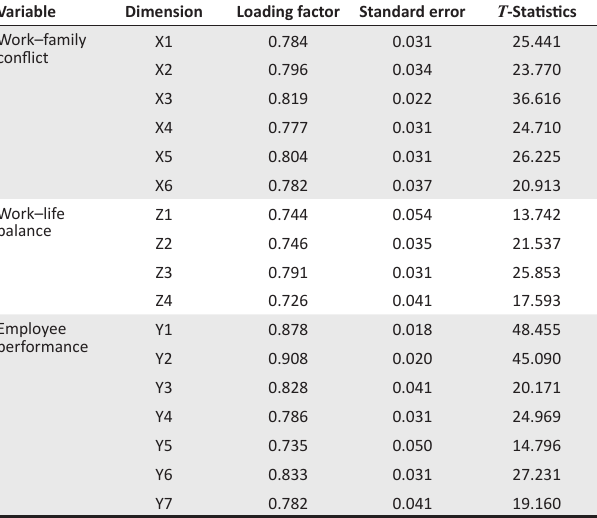
TABLE 2: Convergent validity test results